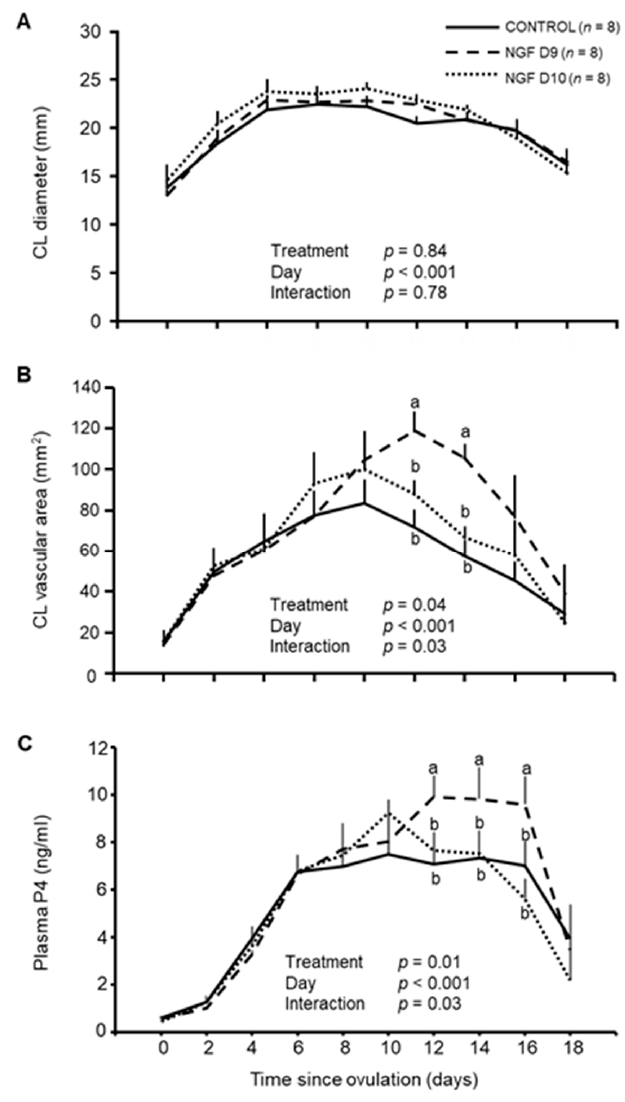
Figure 4. Effect of NGF on luteal function on estrus-synchronized heifers. ( A ) Corpus luteum (CL) diameter profile, ( B ) area of CL vascularization, and ( C ) plasma P4 in heifers treated with PBS (control), NGF D9, or NGF D10. Values are mean ± SEM; values with different superscripts between groups are different ( p < 0.01).